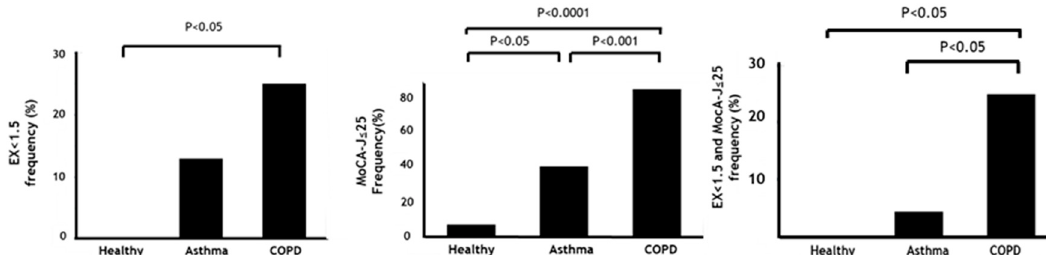
Figure 2. Frequency of sedentary lifestyle, cognitive risk, and MCR among subjects. Data are presented as frequency. P-values show post-hoc analysis between each group. MET: Metabolic equivalent, EX: Exercise (MET × hours), MoCA-J: Japanese version of the Montreal Cognitive Assessment, MCR: Motoric cognitive risk